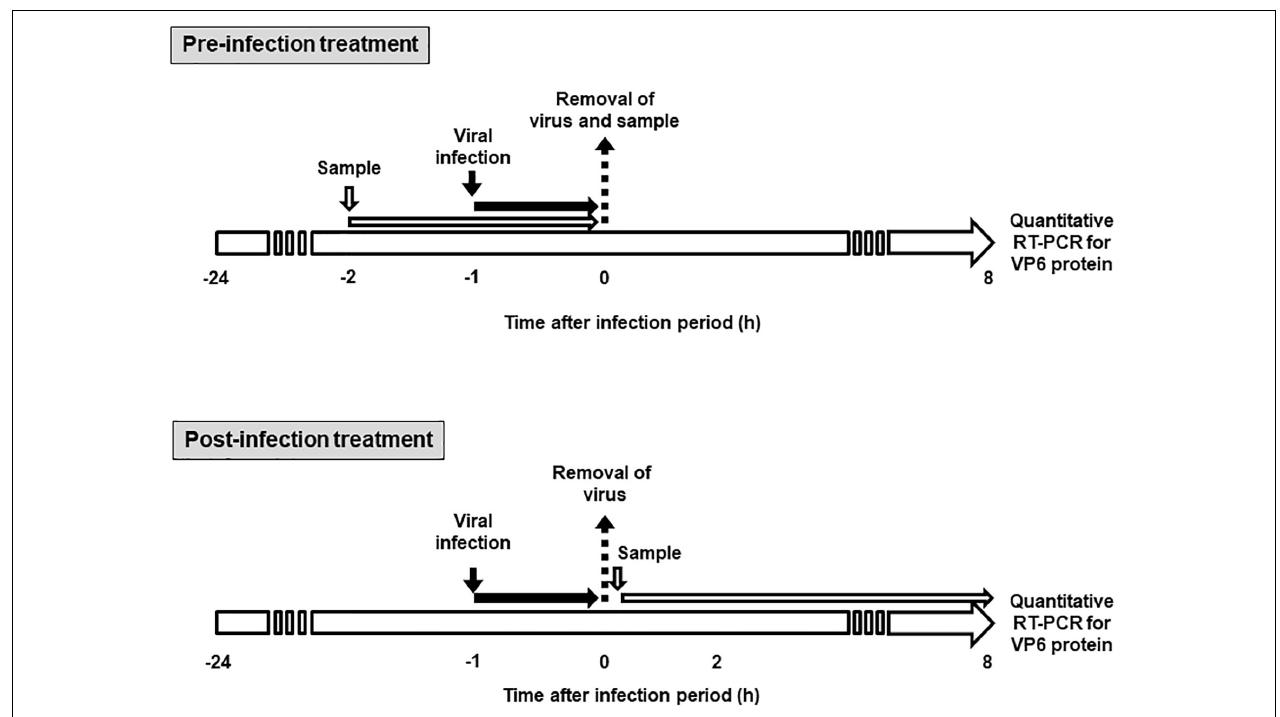
FIGURE 1 | Schematic diagram for sample treatment in rotavirus infection study. In pre-infection treatment, Caco-2 cells were treated with KT-11 LE or KT-11 SLP for 1 h, then infected with the virus for 1 h, and the amplification of VP6 mRNA after 8 h was analyzed by quantitative RT-PCR. In post-infection treatment, Caco-2 cells were infected with the virus for 1 h and then treated with the KT-11 LE or KT-11 SLP for 8 h, and the amplification of VP6 mRNA was analyzed by quantitative